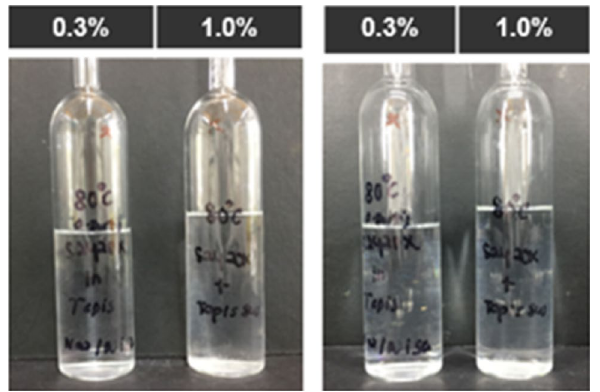
Fig. 11 APG surfactant compatibility and solubility at 0.3% and 1.0 wt% concentration, at 106 °C after 30 days (left) and 60 day